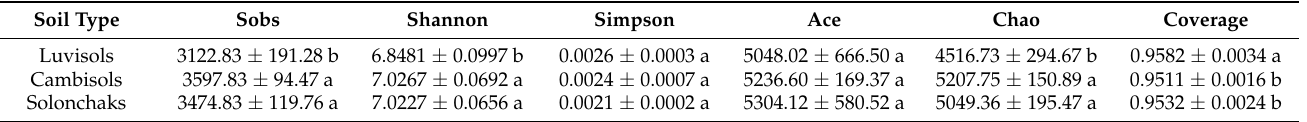
Table 3. Alpha diversity indexes of rhizosphere bacteria in different soil types of pecan plantations. Soil